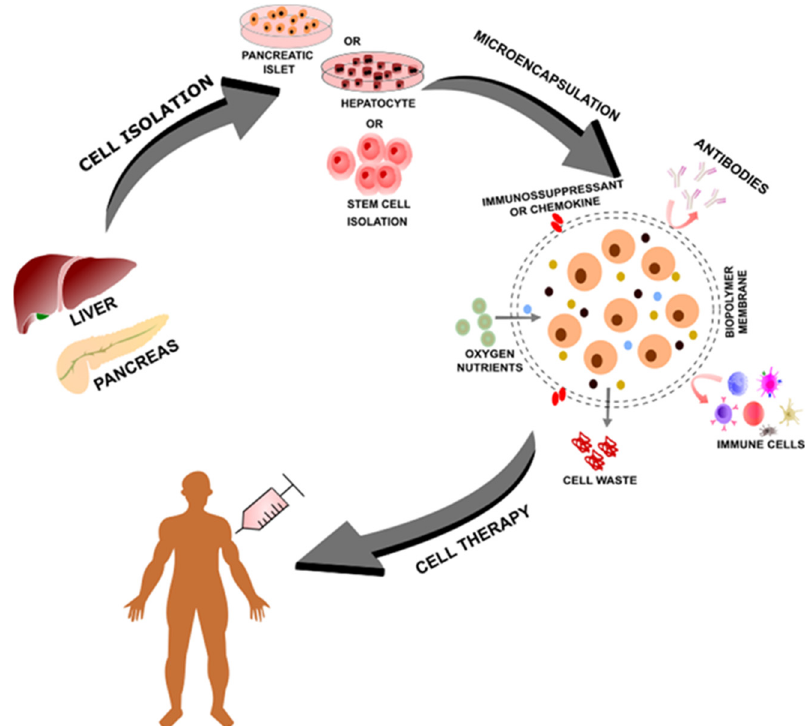
Figure 1. Schematic figure indicating cell microencapsulation. Cells isolated from organs, such as the liver and pancreas, or isolated stem cells may be encapsulated into a semipermeable biopolymer membrane, allowing for nutrient exchanges between the extra- and intracellular environments. This bidirectional link enables the entry of oxygen and growth factors and the exit of cell waste. Furthermore, the biopolymer membrane allows for decreased immunogenicity, with the inhibition of immune cell induction and antibody responses.